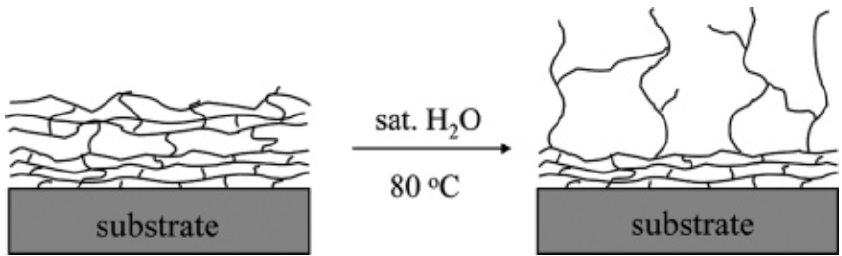
Figure 10. Schematic of silane film structure pre- and post-exposure to water, as determined by the NR model fit. Figure reproduced with kind permission from [122], ACS Publications, 2005.